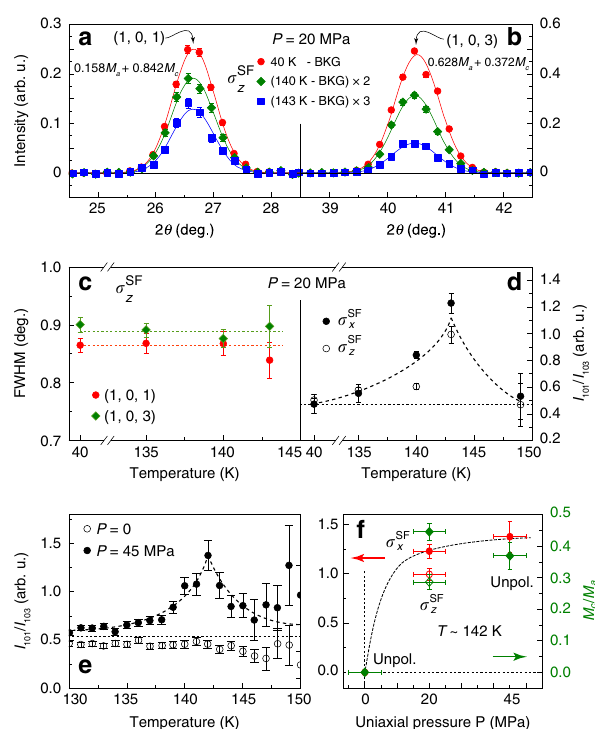
Fig. 4 Uniaxial pressure dependence of the magnetic order and correlations. Elastic θ /2 θ scans of σ SF z across a Q 1 = (1, 0, 1) and b Q 2 = (1, 0, 3) at different temperatures and P = 20 MPa. The data are collected on BT-7 using fi nal neutron energy of 14.7 meV with instrumental energy resolution of about 1.3 meV. Similar scans of σ SF z are discussed in Supplementary information for additional data and analysis. σ SF y was unavailable at the time of this experiment. c FWHM of the elastic (1, 0, 1) and (1, 0, 3) scans across T N / T s . d Temperature dependence of I 101 / I 103 ∝ (0.16 M a + 0.84 M c )/(0.63 M a + 0.37 M c ). e Temperature dependence of I I P ≈ 0 and ~ 45 MPa uniaxial pressure obtained using in-situ 101 / 103 at uniaxial pressure device with unpolarized neutrons on BT-7. f Pressure dependence of I 101 / I 103 (red symbols, left axis) and M c / M a (green symbols, right axis) at T ~ 142 K. The data points for P = 0 and 45 MPa were measured with unpolarized neutron scattering. The data points for P = 20 Mpa were measured with polarized mode with the open (solid) symbols obtained from σ SF z ( σ SF x ). The black dashed curve is a guide to the eye for the data points. unpol. denotes unpolarized neutron scattering measurements. The vertical error bars in ( a , b , d , e ) represent statistical errors of 1 standard deviation. The error bars in ( c ) are estimated errors from fi ts to magnetic Bragg peak widths. The error bars in ( f ) are our estimated errors from fi ts to magnetic order parameters and applied uniaxial